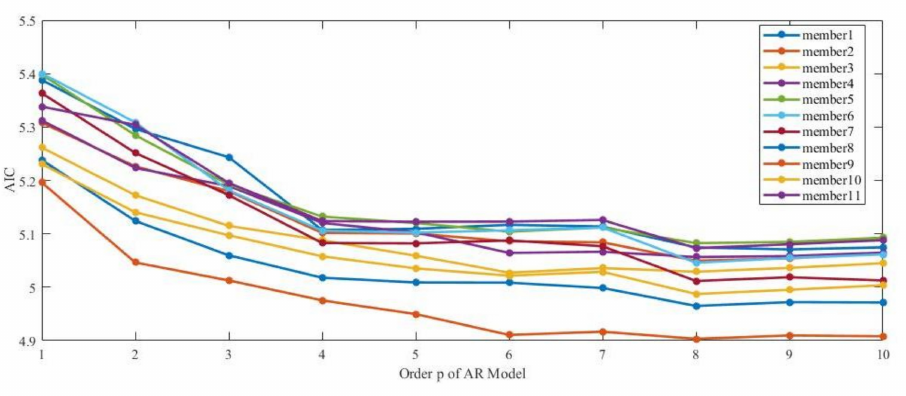
Figure 3. The AIC value of each ensemble